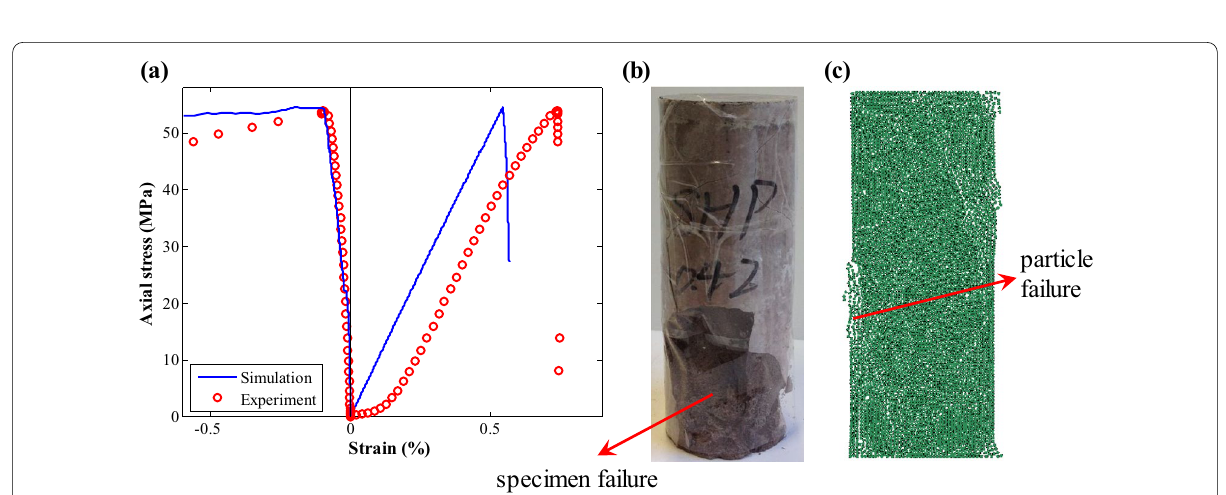
Fig. 17 Comparison between the numerical and experimental UCS results when the water–cement rate was 0.42: a stress–strain curves; b experimental failure mode; c numerical failure